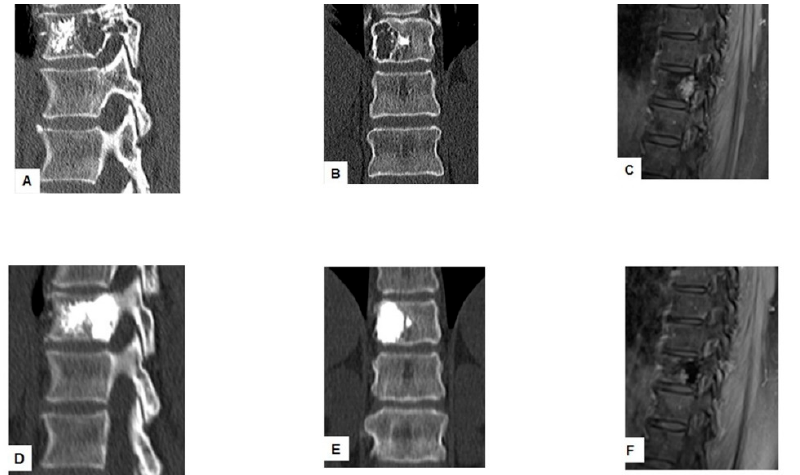
Figure 3. Successful treatment with tRFA and vertebroplasty with VA of a painful vertebral metas- tasis in a 74-year-old man with metastatic colon cancer. The lesion located in the posterior vertebral wall of T10 was initially treated with vertebroplasty ( A , B ). MRI scan T1 fat suppression shows pro- gression of the lesion after vertebroplasty ( C ). tRFA was performed in the posterior vertebral body: axial and coronal CT scan reconstruction after tRFA followed by vertebroplasty ( D , E ). Postproce- dural MRI scan T1 fat suppression after tRFA and vertebroplasty showed lack of contrast enhance- ment of the lesion ( F